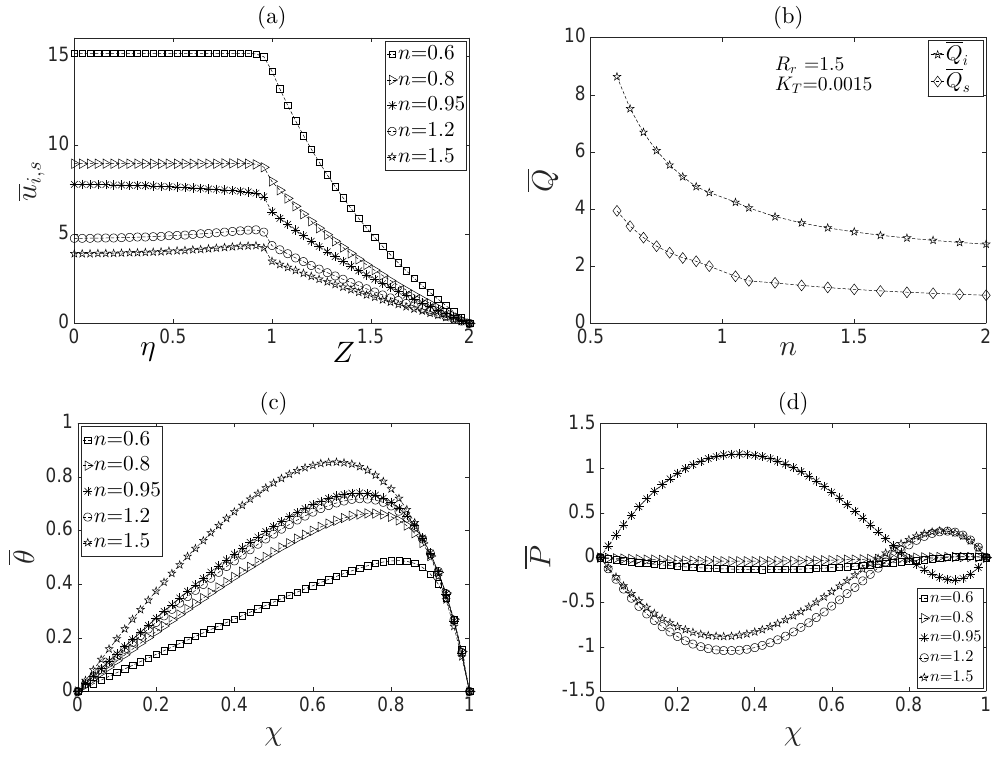
Figure 6. Behavioroftheelectroosmoticflowwithrespecttothepower-lawindex n : ( a )dimensionless velocity profiles, ( b ) dimensionless flow rate, ( c ) dimensionless temperature and ( d ) dimensionless pressure.